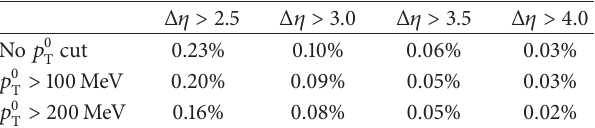
Table 7: The fraction of SDD events which have at least one neutral particleinZDC 󸀠󸀠 (theZDCdetectoronthesidewiththegap)isgiven for different cuts on the size of the Δ𝜂 and with different thresholds for the transverse momentum of the neutral particles. The gap is defined as an edge gap and the final state particles within |𝜂| < 5.2 with 𝑝 T > 200 MeV are used to find the size of the